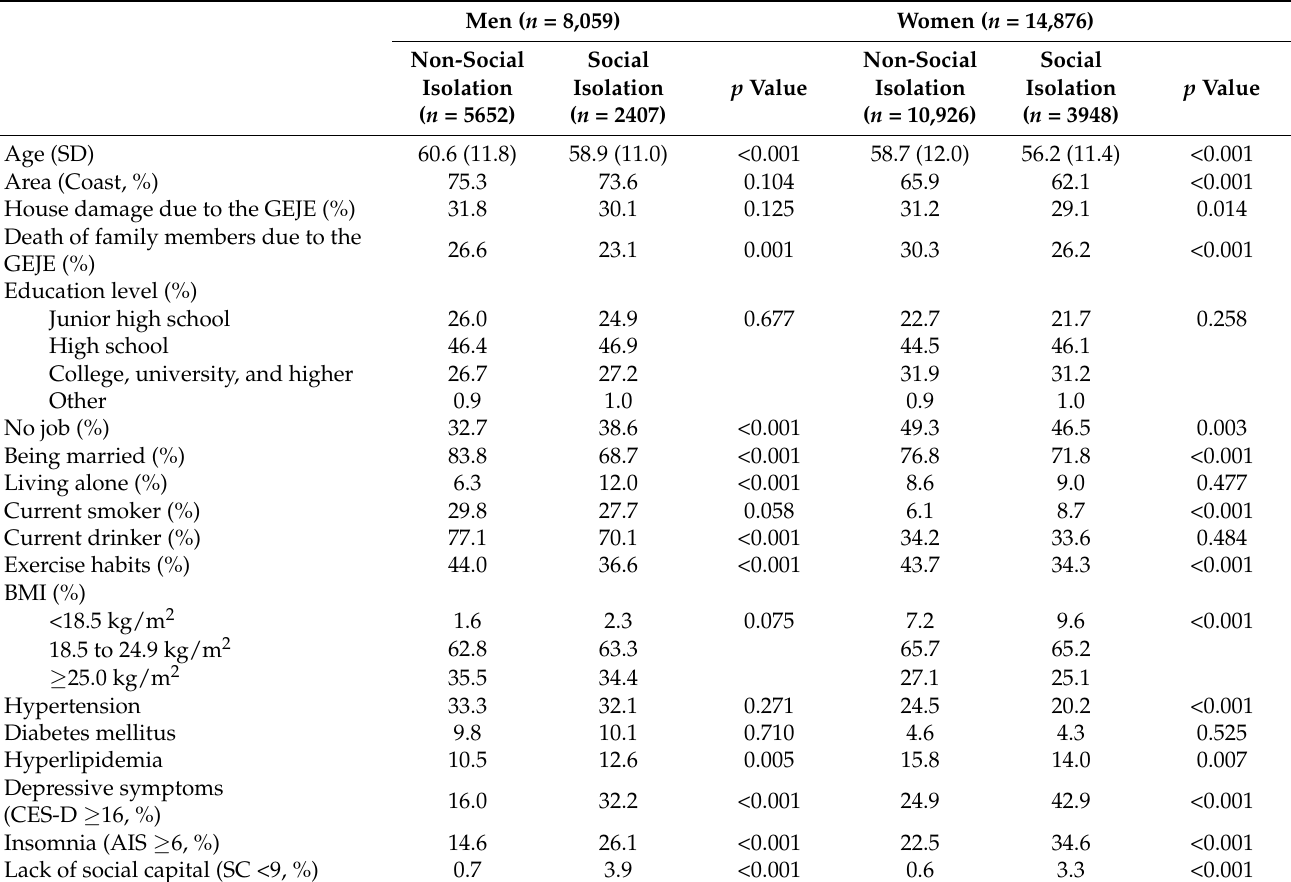
Table 1. Characteristics of the participants according to the presence or absence of social isolation by sex ( n =